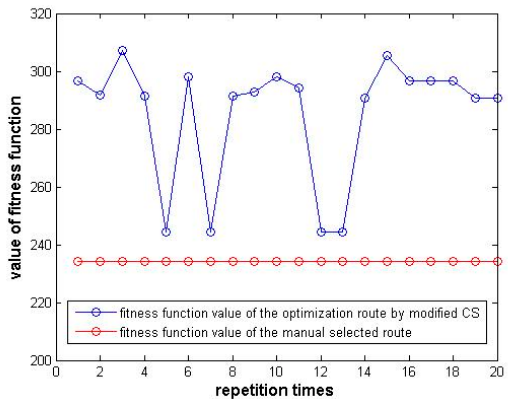
Figure 15. The final fitness function values after 1000 iterations with 20 repetitions of the modified CS.